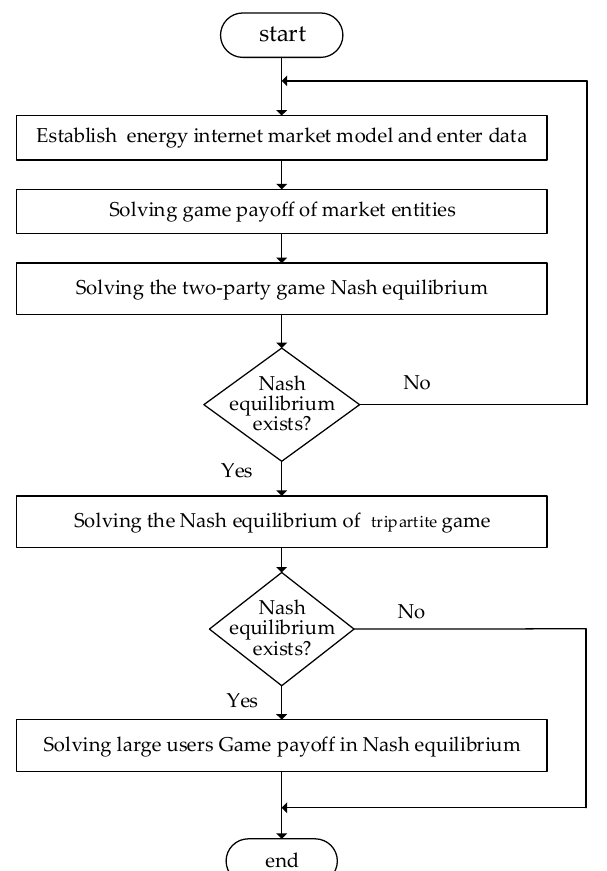
Figure 3. The process of solving Nash equilibria for the proposed tripartite game model.